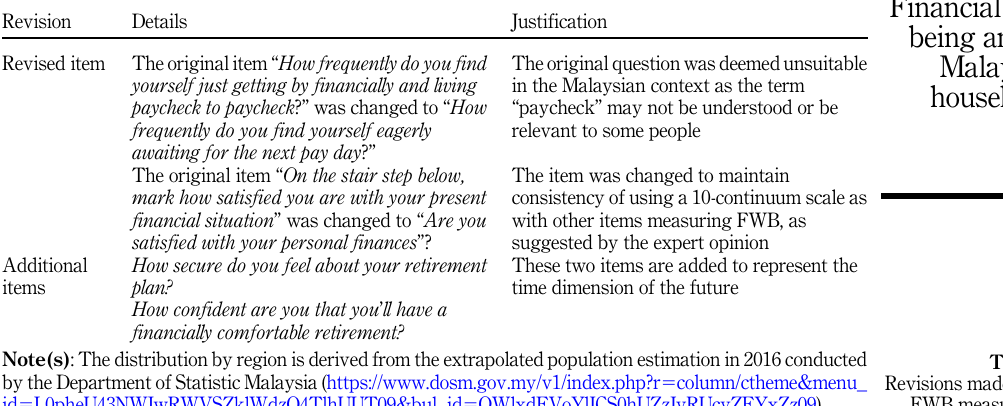
Table 2. Revisions made on